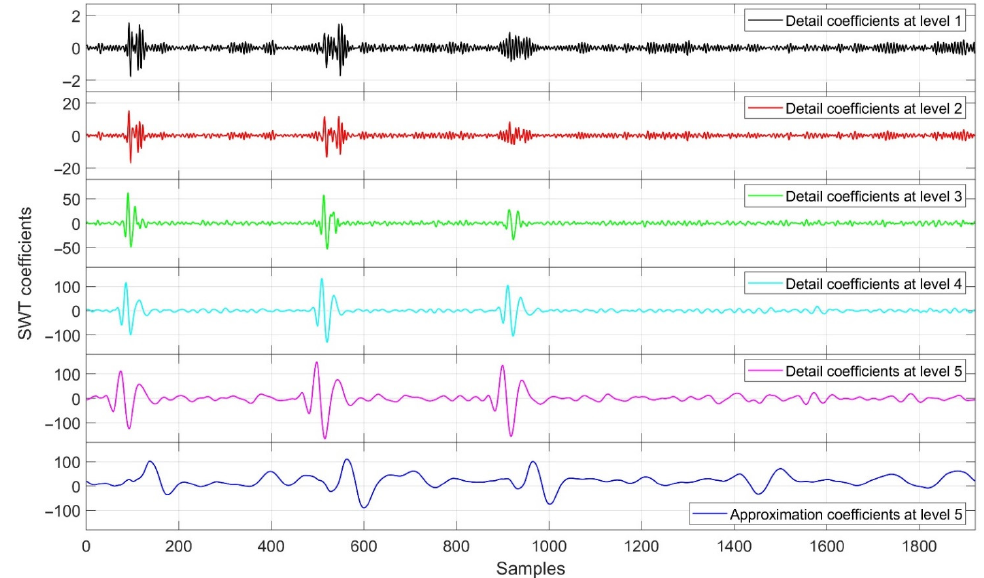
Figure 4. SWT coefficients up to level 5 of the corrupted EEG shown in the top panel of Figure 2 using Daubechies wavelet with vanishing moment as 4.